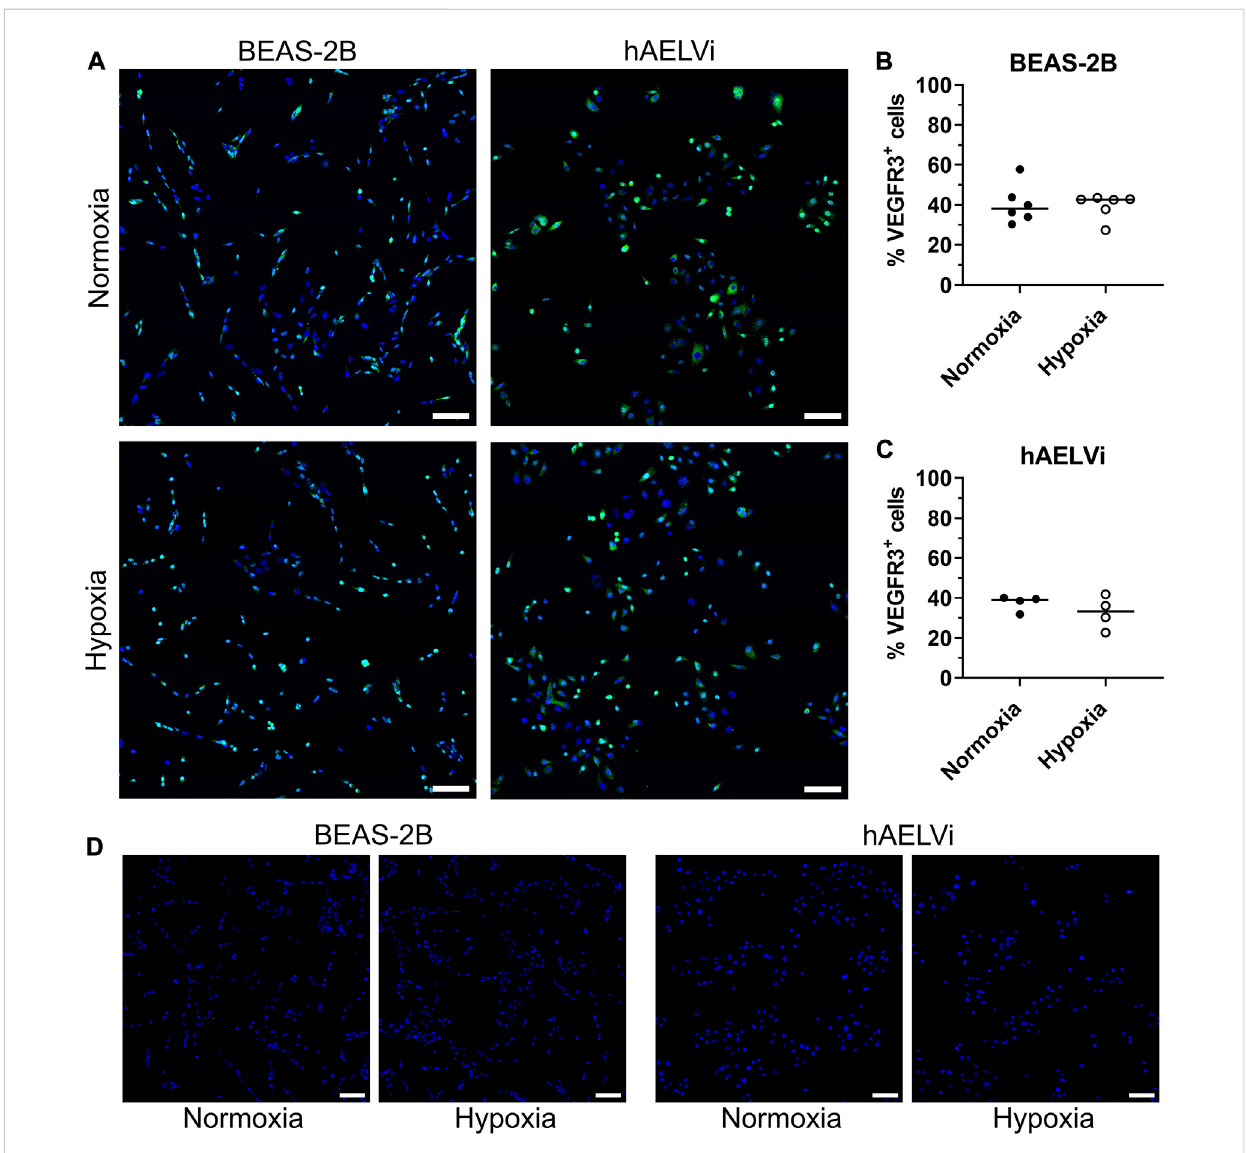
FIGURE 4 Immuno fl uorescence staining of VEGFR3 in BEAS-2B and hAELVi cells exposed to normoxia or hypoxia exposure (A) . DAPI (blue) and VEGFR3 (green).Scalebar=100 µm.AnalysisofVEGFR3 + cellsinBEAS-2B (B) andhAELVi (C) .Controlstainingwithouttheanti-VEGFR3primaryantibody (D) .DAPI (blue) and VEGFR3 (green). Scale bar = 100